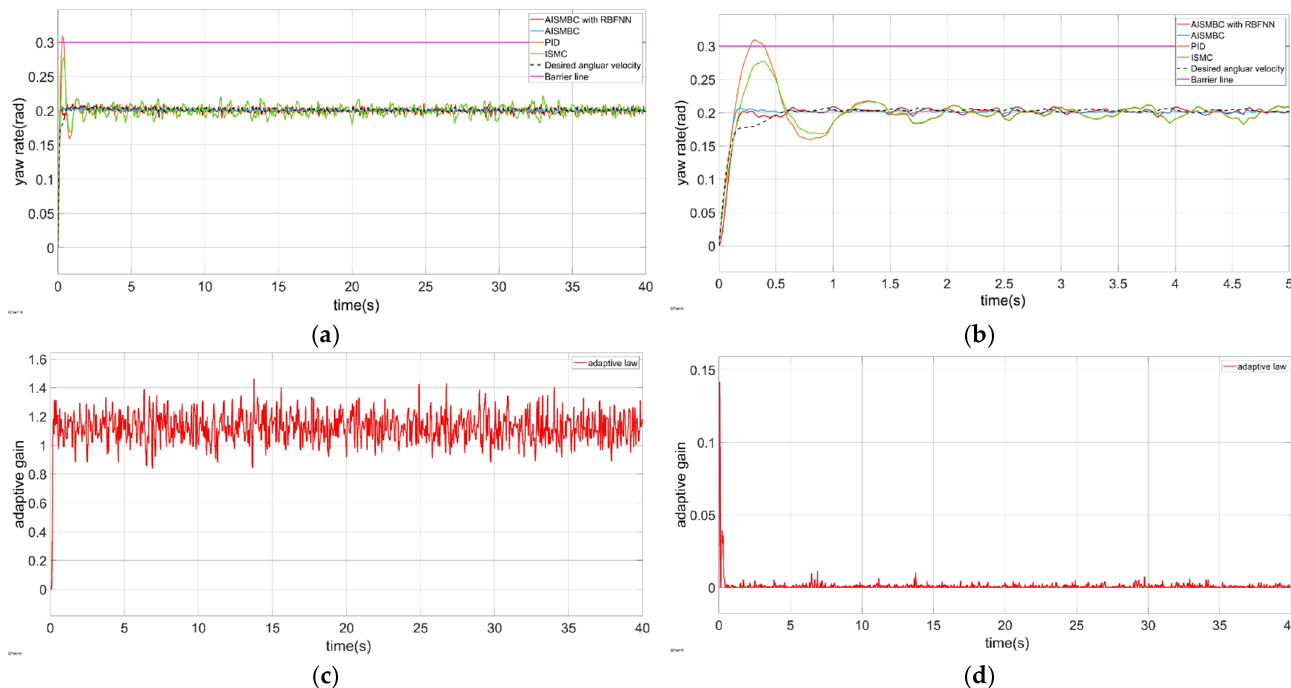
Figure 17. The control results of the yaw angular velocity with the random lumped disturbance. ( a ) The control results when the acceleration of yaw angle was subjected to the random lumped disturbance. ( b ) Local amplification. ( c ) Adaptive gain of AISMBC. ( d ) Adaptive gain of AISMBC with RBFNN.